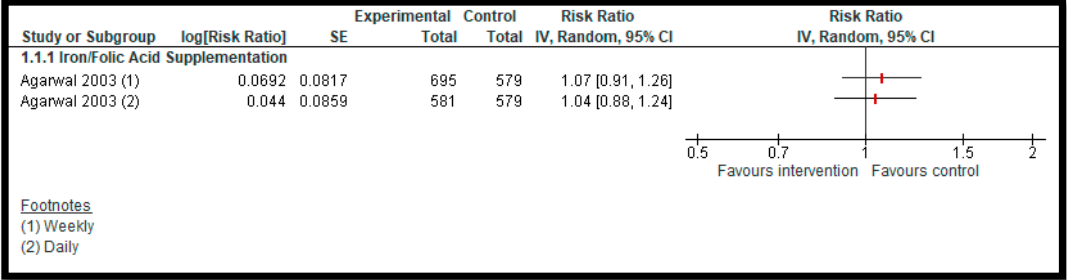
Figure 3. Impact of iron supplementation with or without folic acid on anemia.